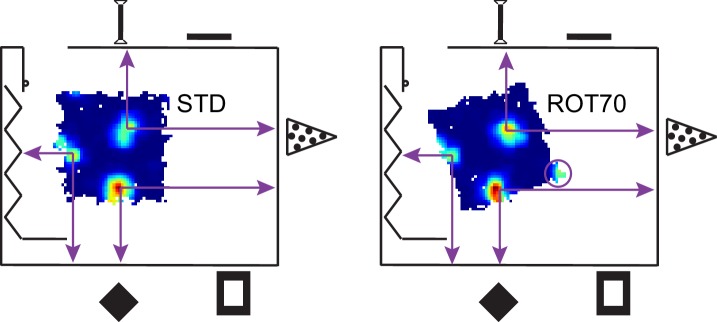
Illustration of a room-anchored grid.The rate maps for the STD and ROT70 sessions of the same grid cell are shown within the room schematic (same as in Figure 1), approximately in scale and in position. Note how the position of the firing fields remain roughly stable relative to the room coordinate system. Note also how a fourth firing field (in circle) appears in ROT70 as the platform extends to the expected position of the vertex in room space. The grid thus appears embedded in the metric structure of the room, rather than the platform frame of reference. A large-scale grid was chosen here for ease of illustration. Grids of smaller scale exhibiting similar properties are reported in Figure 3D and Figure 3—figure supplement 2.